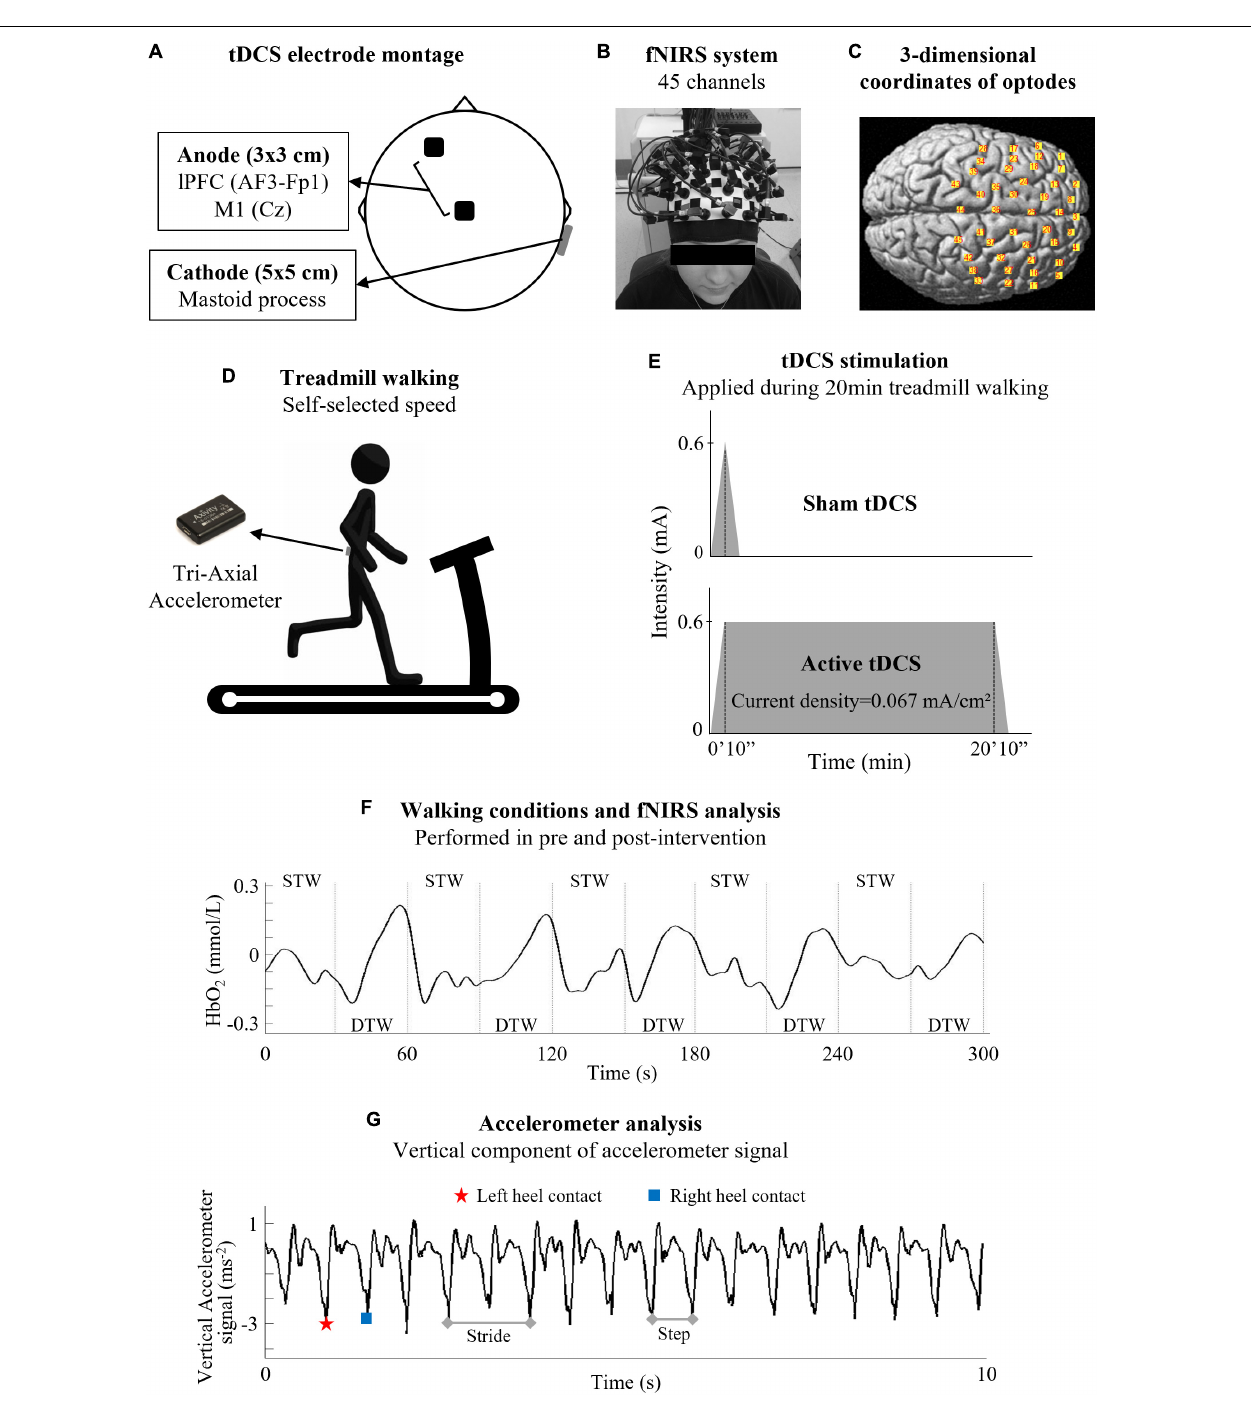
FIGURE 2 | Experimental setup. (A) Transcranial direct current stimulation (tDCS) was positioned over the left prefrontal cortex (lPFC) and Cz (i.e., the vertex, which overlies the primary motor cortex - M1), following the 10/20 EEG system. After tDCS positioning, (B) a headcap with fNIRS optodes was positioned on the participants’ head. (C) Spatial registration of the 45-channels was calculated using a digitizer (FASTRAK) to confirm the optode position. (D) A tri-axial accelerometer was positioned over the 5th lumbar vertebra. Then, participants performed two bouts of 5-min mixed treadmill walking before and after 20-min treadmill walking combined with tDCS protocol. (E) Participants were randomly allocated to active tDCS intervention and received a 0.6 mA stimulation for 20-min, or sham tDCS intervention, and received a 0.6 mA stimulation for only 10 s. (F) The 5-min mixed treadmill walking consisted of 10 trials of alternating 30 s for both single task walking (STW) and dual task walking (DTW) bouts. HbO 2 concentration from the STW was subtracted from the DTW to evaluate the relative change in HbO 2 concentration ( (cid:49) DTW − STW ). (G) Gait cycles were calculated using the accelerometer and the cognitive-motor interference was also calculated (difference between DTW and STW).